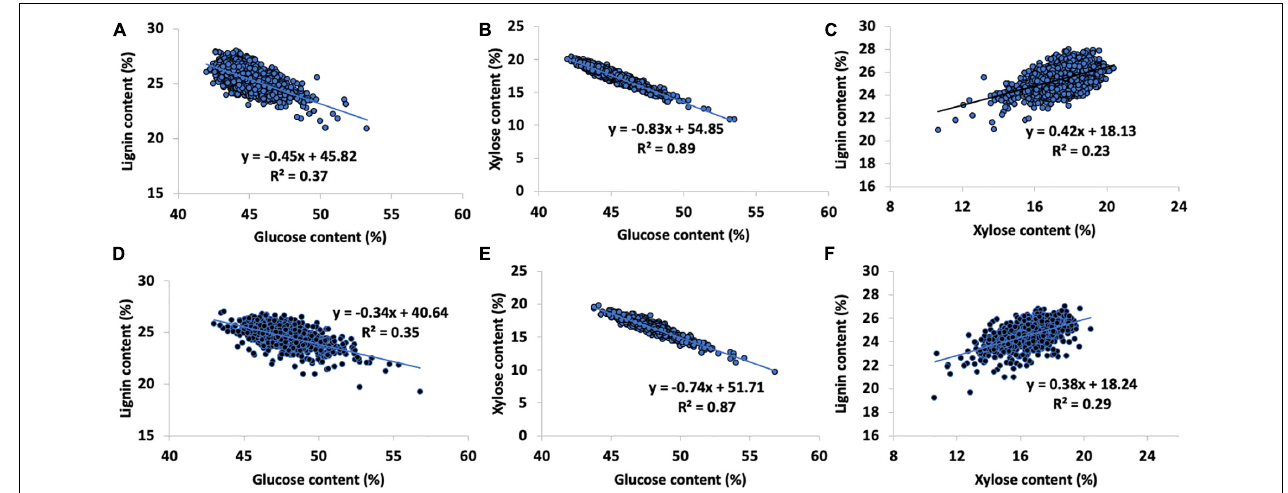
FIGURE 4 | Relationships between biopolymer components in the pedigree [(Top, A ) lignin vs. glucose content, (B) glucose vs. xylose content, (C) lignin vs. xylose content] and natural variant [(Bottom, D ) lignin vs. glucose content, (E) glucose vs. xylose content, and (F) lignin vs. xylose content] P. trichocarpa sets. Natural variant sugar contents shown used hydrolysis-NMR validation data to minimize propagated error in the py-MBMS